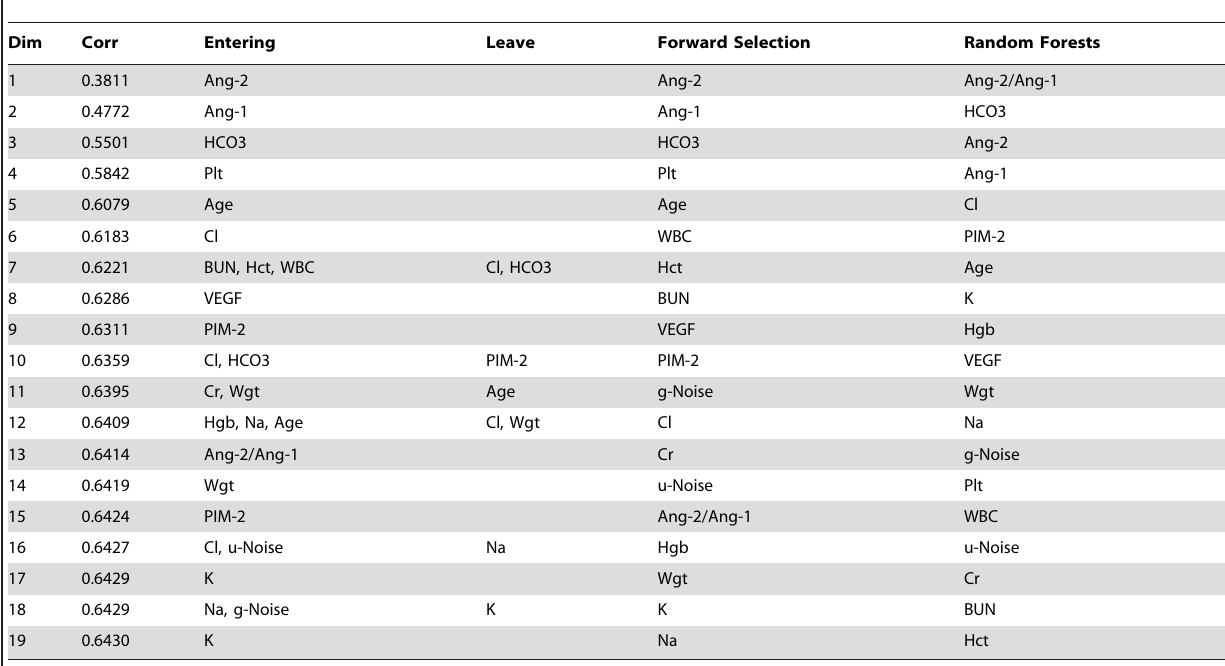
Table 1. Stepwise Biomarker Selection using Canonical Correlation Analysis, Forward Selection and Random Forests.